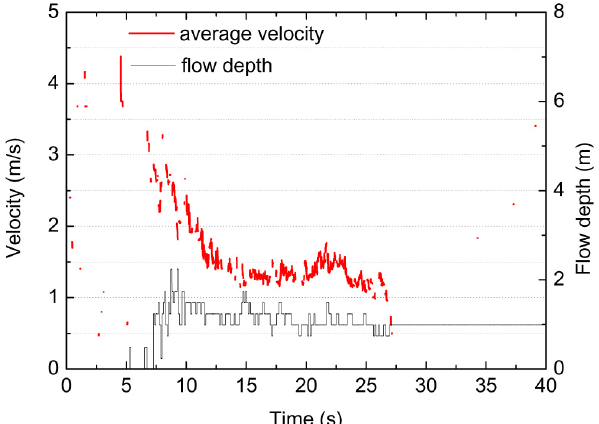
Fig. 14. Avalanche 4. Flow depth and internal velocities measured at the pylon, close to cavern C. This avalanche was characterized at the beginning of the runout zone by a small dense flow with velocity up to 4ms − 1 to 5ms − 1 and flow depth in the order of